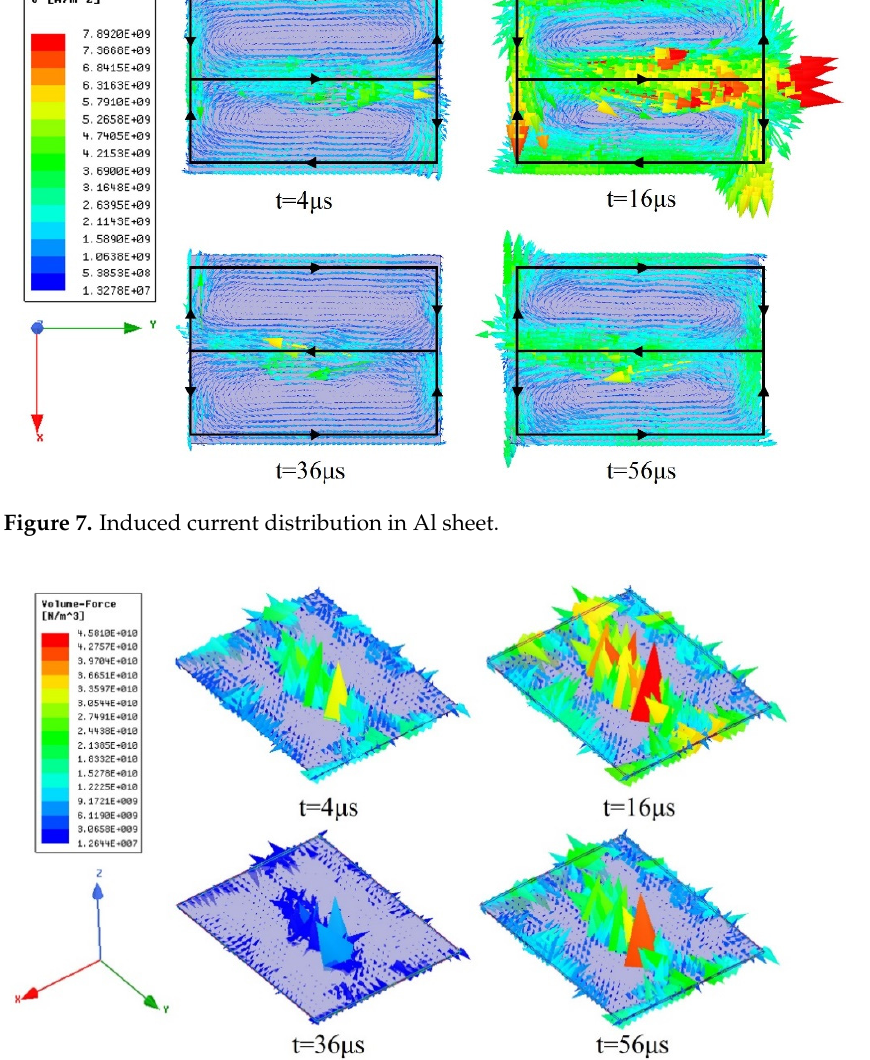
Figure 7. Induced current distribution in Al sheet.